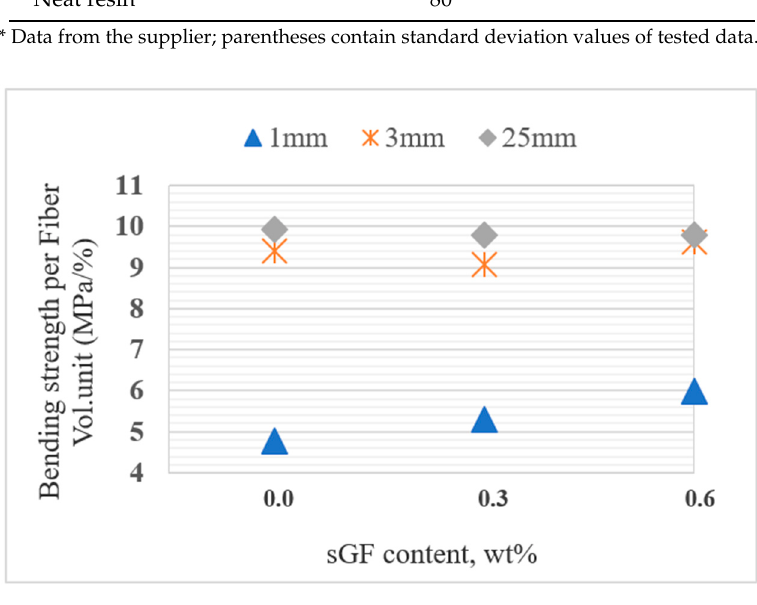
Figure 7. The bending strength of composites with respect to carbon fiber (CF) length and sGF addition content.